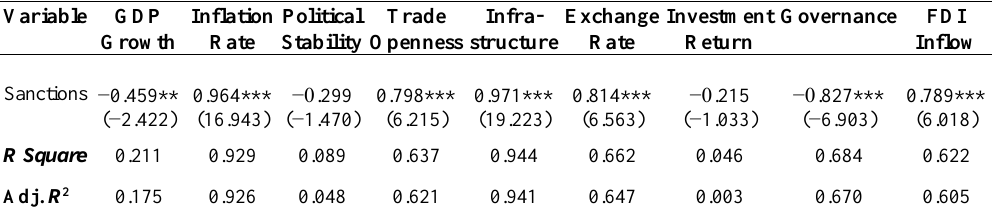
Table 4. Linear Regression (Effect of Sanctions on Macroeconomic Factors)